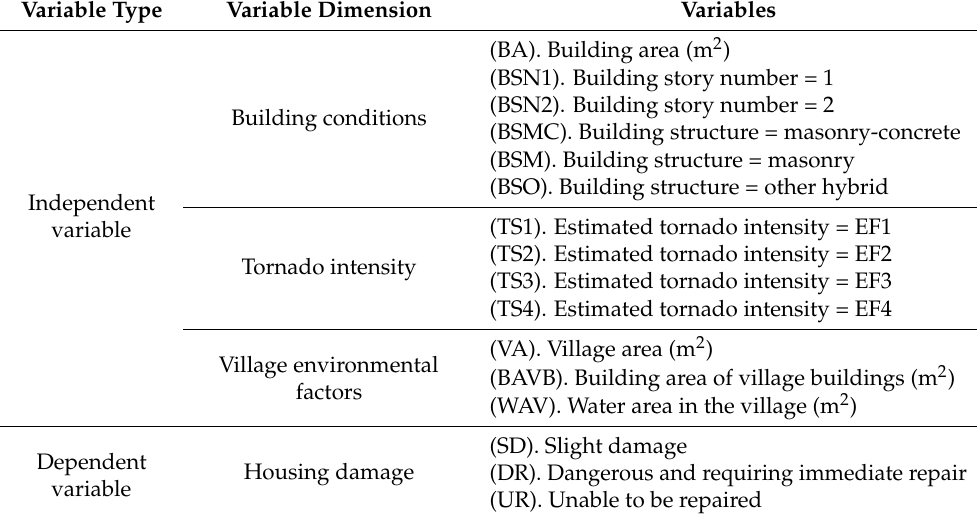
Table 1. Analysis